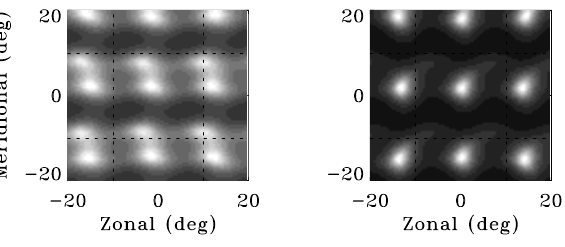
Fig. 2. Two maps of brightness distribution resulted from the CRI- Capon’s